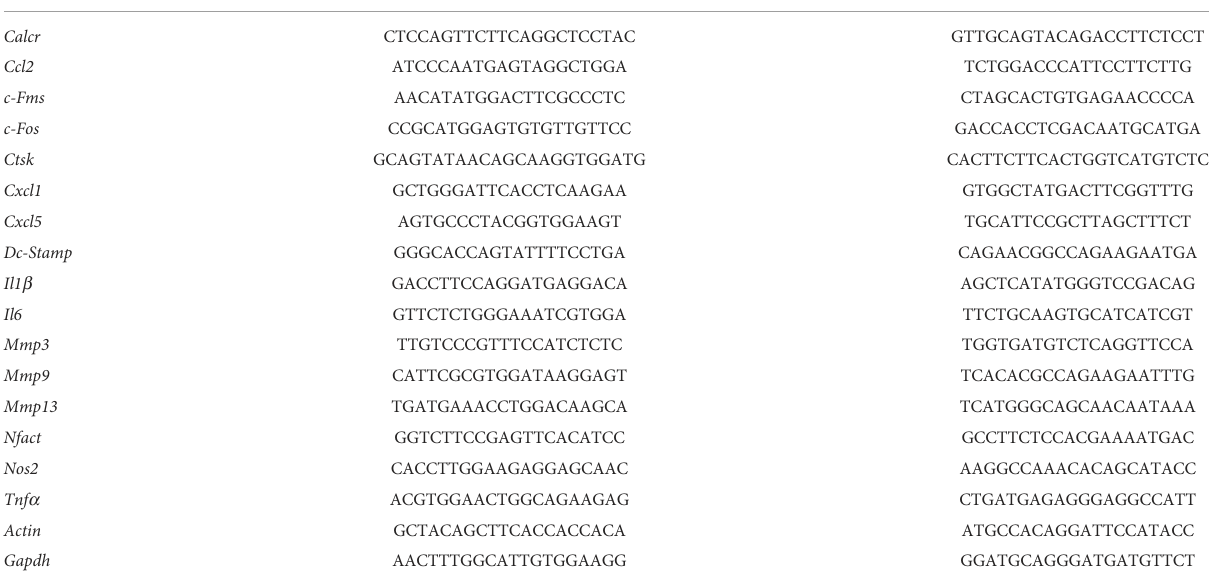
TABLE 2 Primers used for quantitative